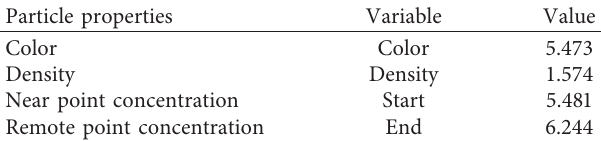
Table 1: The realization of ink painting style rendering.